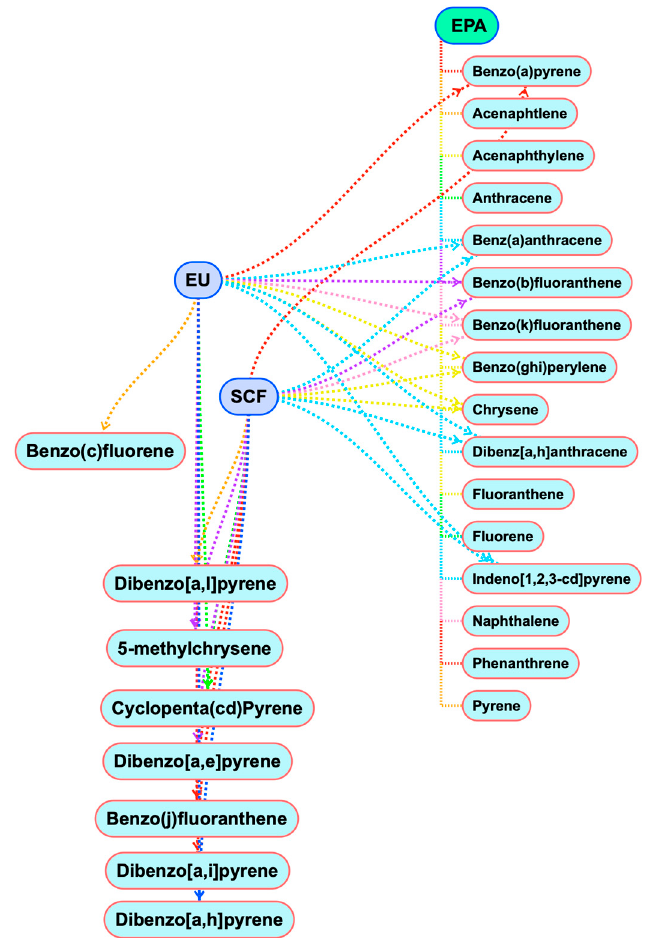
Figure 2. PAHs considered to be a priority by the EU Scientific Committee for Food (SCF), the European Union (EU) and the US Environmental Protection Agency (EPA).